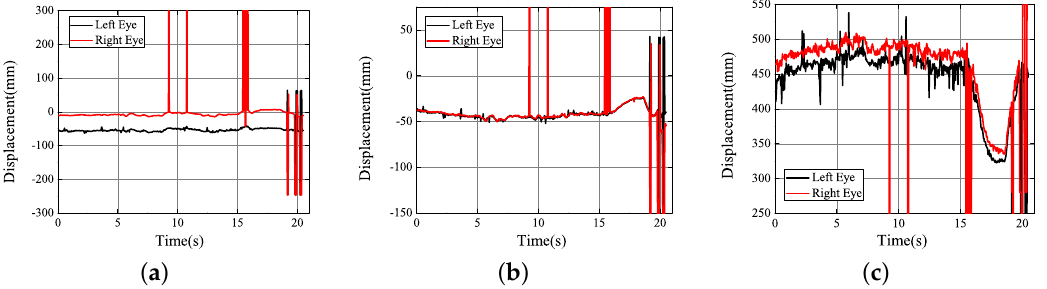
Figure 22. Experimental results obtained (30 km/h): ( a ) X axis; ( b ) Y axis; ( c ) Z axis.